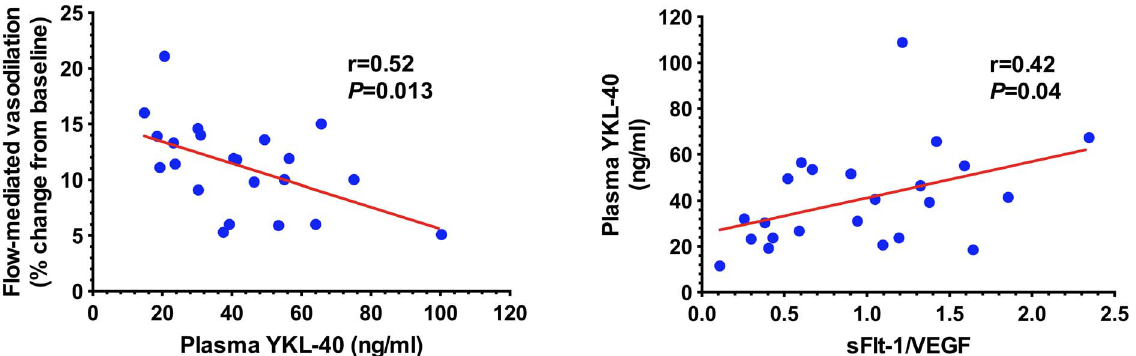
Figure 2. Plasma YKL-40 and sFlt-1/VEGF. YKL-40 correlated inversely with flow-mediated vasodilation whereas there was a positive correlation between YKL-40 and sFlt-1/VEGF, a measure of decreased free VEGF availability or anti-angiogenic state.